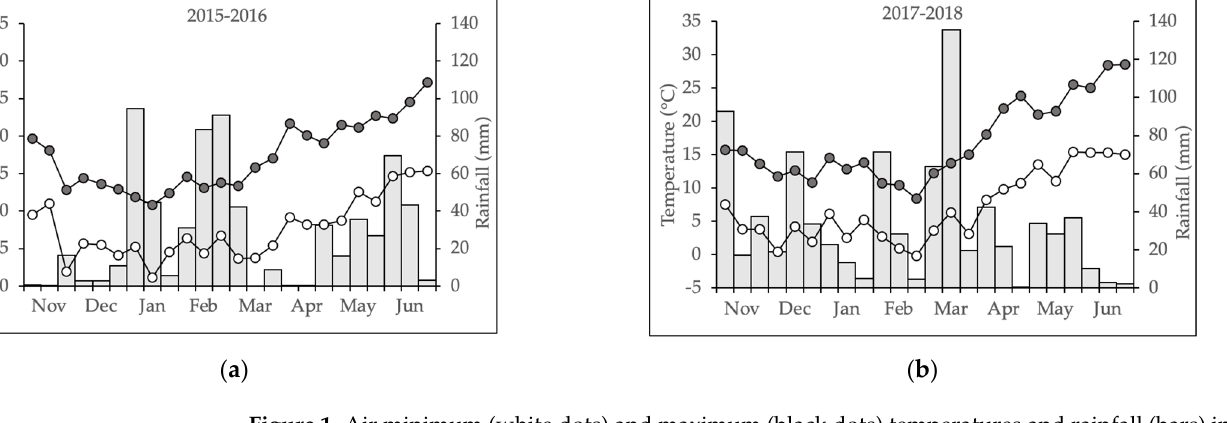
Figure 1. Air minimum (white dots) and maximum (black dots) temperatures and rainfall (bars) in the two cropping seasons: ( a ) 2014–2015; ( b ) 2015–2016.